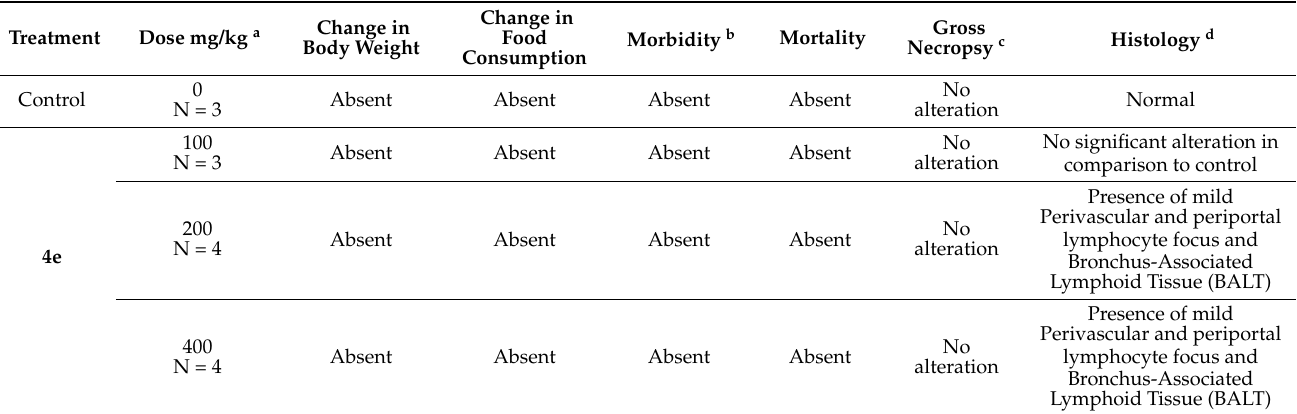
Table 3. Acute toxicity study: morbidity, mortality, gross organs necropsy, and histology of mice treated with compound 4e . For more information and results, see supplemental Table S1.